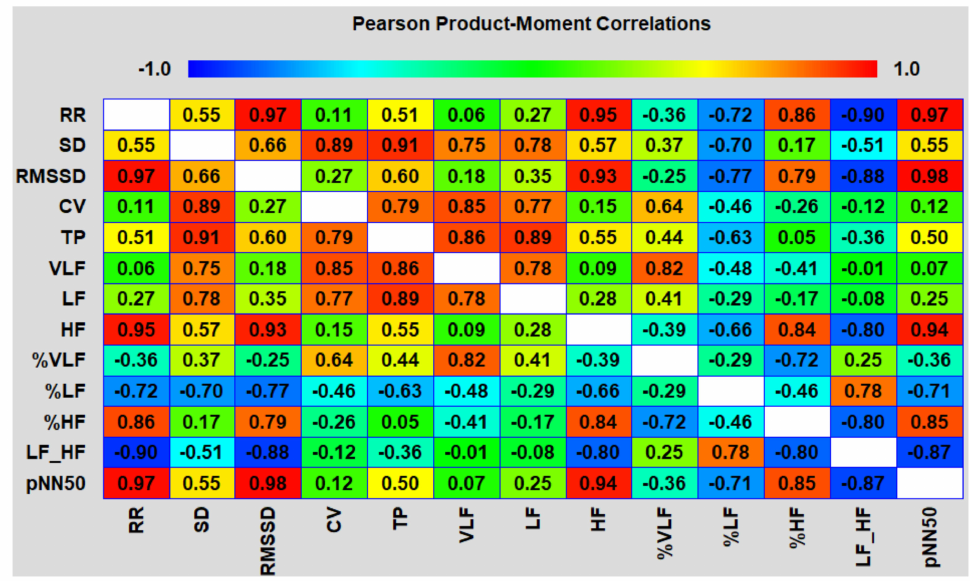
Figure 14. Correlation matrix between the HRV indices at the initial stage (with the descriptor 0 at the end) of the test packs in the interval of 0–3 h (up to the point of intersection of the two green straight trend lines in Figure 14, corresponding to 13 h 30 min).